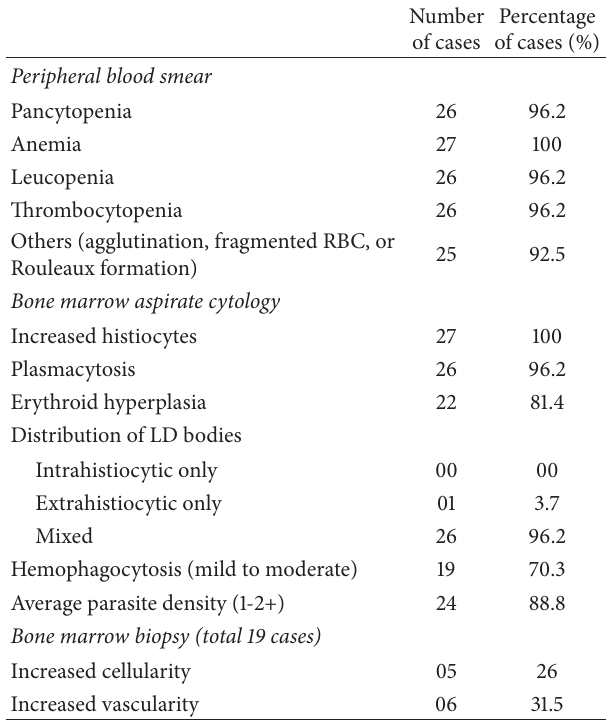
Table 2: Common hematological and bone marrow findings observed in leishmaniasis.